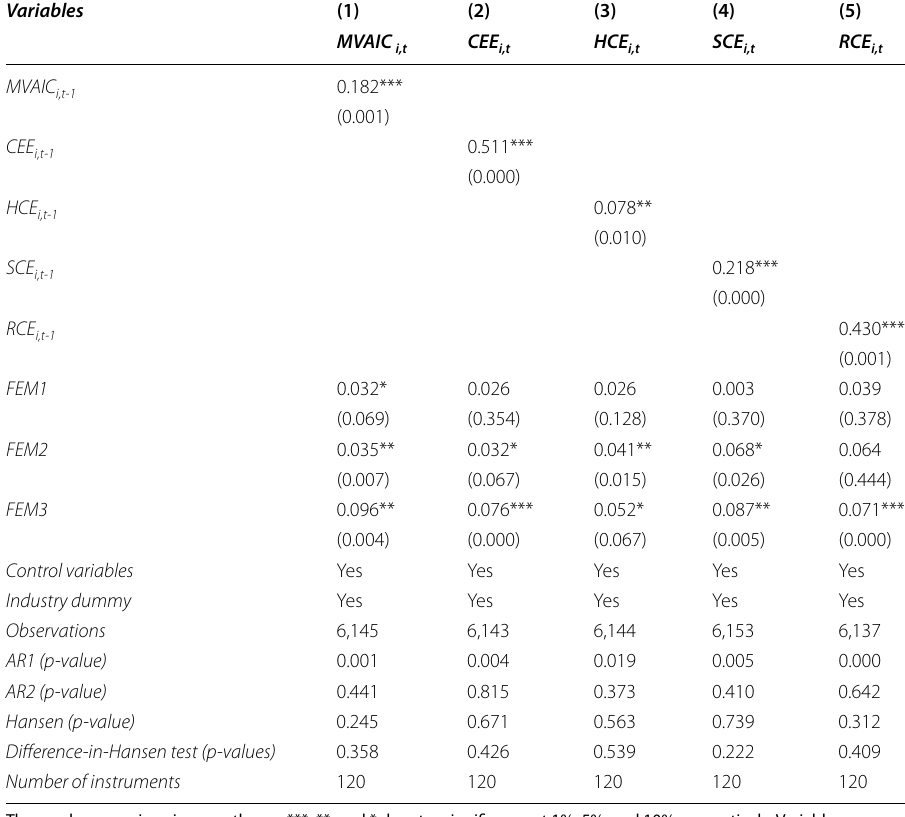
The p-values are given in parentheses. ***, **, and * denotes significance at 1%, 5%, and 10%, respectively. Variable definitions are provided in Table